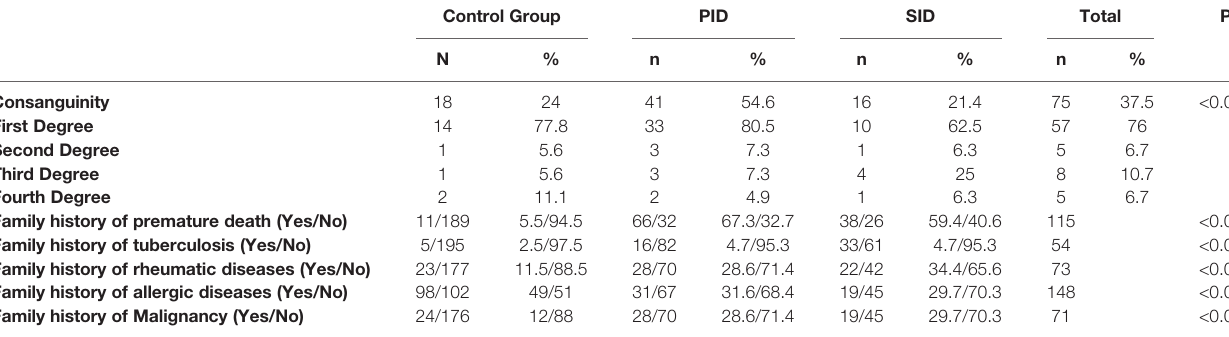
TABLE 3E | Distribution of family history features of the patients and the controls by the groups.